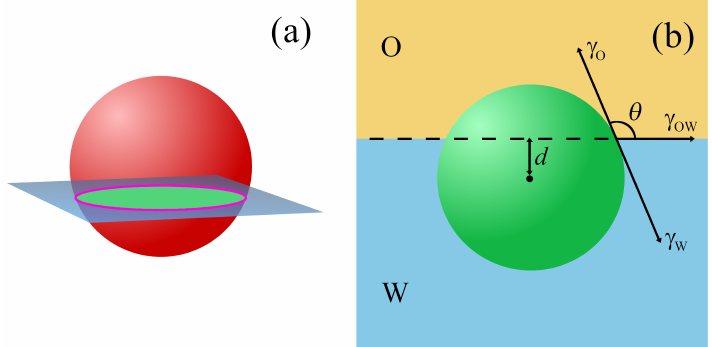
Figure 1. A spherical particle at a fluid/fluid interface (O/W). ( a ) The area of the fluid interface that is removed upon adsorption of the particle (green area) and the three-phase contact line associated with the line tension (magenta line). ( b ) The interface tension vectors, γ O and γ W , are the interface tensions between the particle and the fluids, and γ OW is the interfacial tension corresponding to the fluid interface. R denotes the particle radius, θ is the contact angle, and d is the a position of the particle